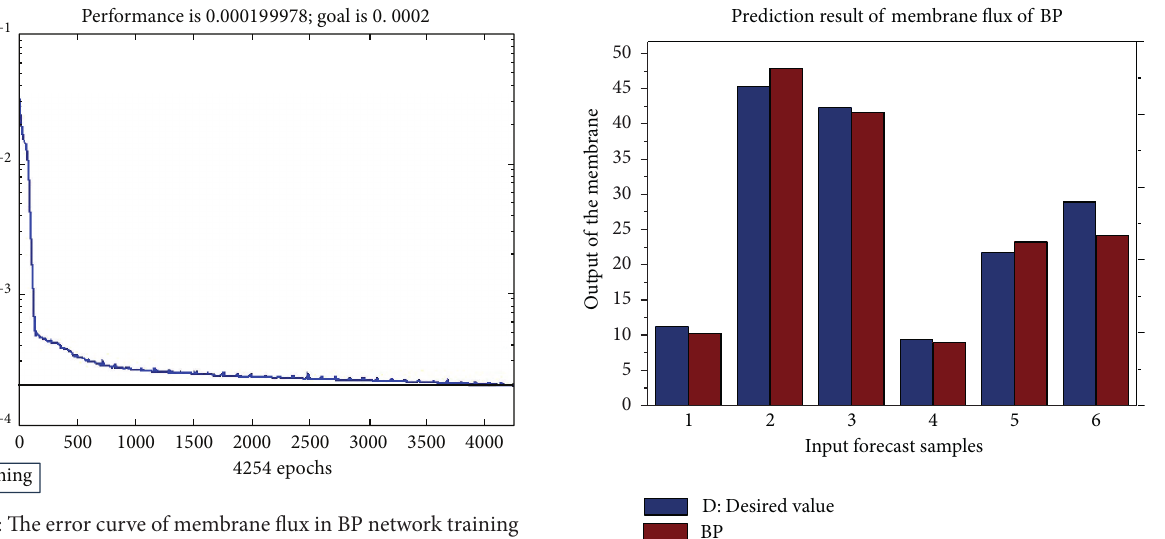
Figure 1: The error curve of membrane flux in BP network training process.